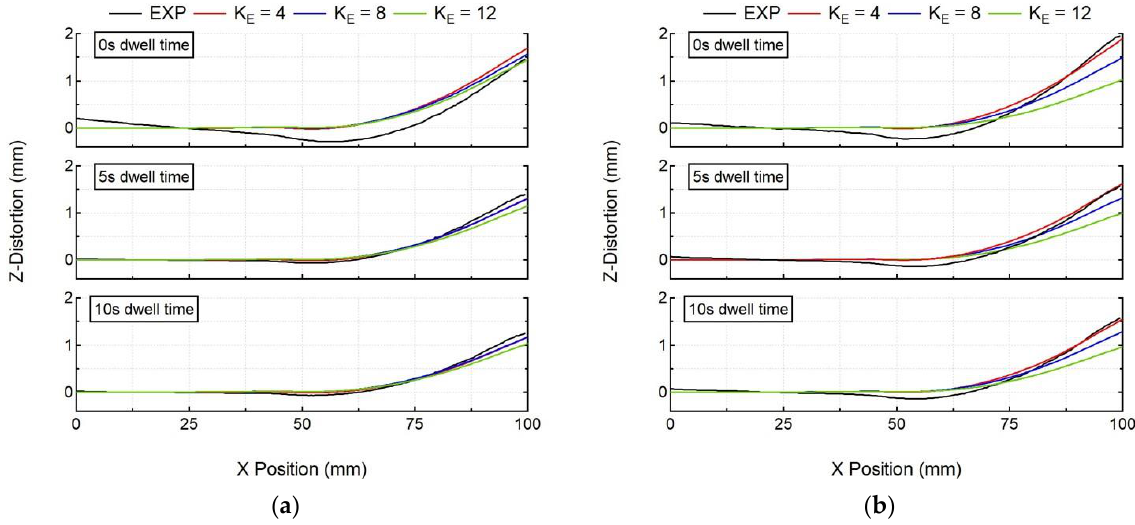
Figure 14. Comparison of numerical results using the elongated ellipsoid with experimental post-process line distortion results of the optical scanner for all cases ( a ) single-bead wall, ( b ) double-bead wall.